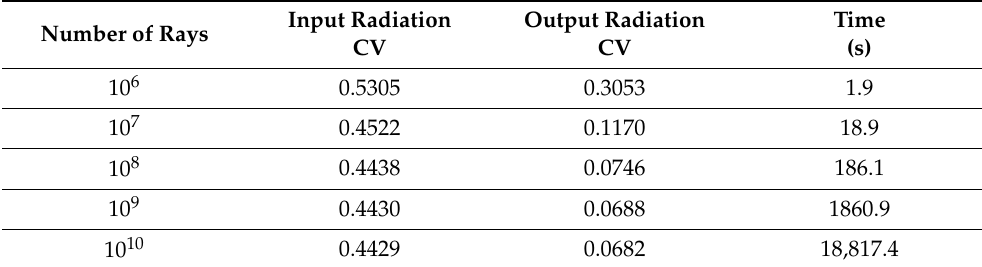
Table 1. Model dependence on the number of input rays. Input Radiation Number of Rays